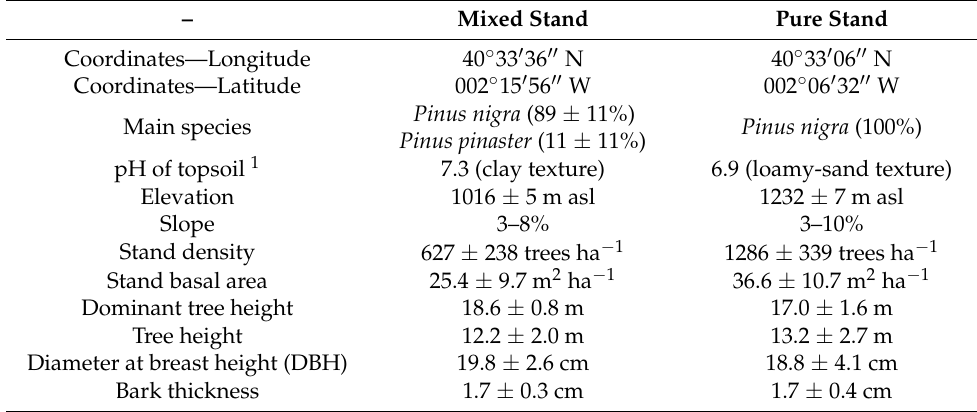
Figure 1. Locations of the study plots in ( a ) the Iberian Peninsula (1:1,250,000); ( b ) El Pozuelo (mixed P. nigra - P. pinaster stand) and Beteta (pure P. nigra stand) (1:50,000). Table 1. Main characteristics of mixed and pure stands (mean and standard deviation) [46].